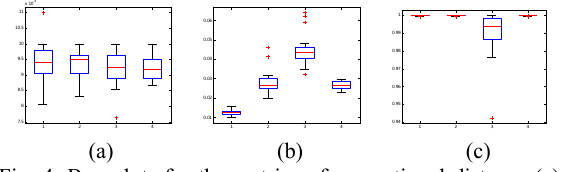
Fig. 4. Box plots for the metrics of generational distance (a), spacing (b), maximum spread(c), KMOPSO (1), NSGA-II (2), MOPSO (3), MOPSO-CD (4). Table 2 . Results of the generational distance metric for SCH.